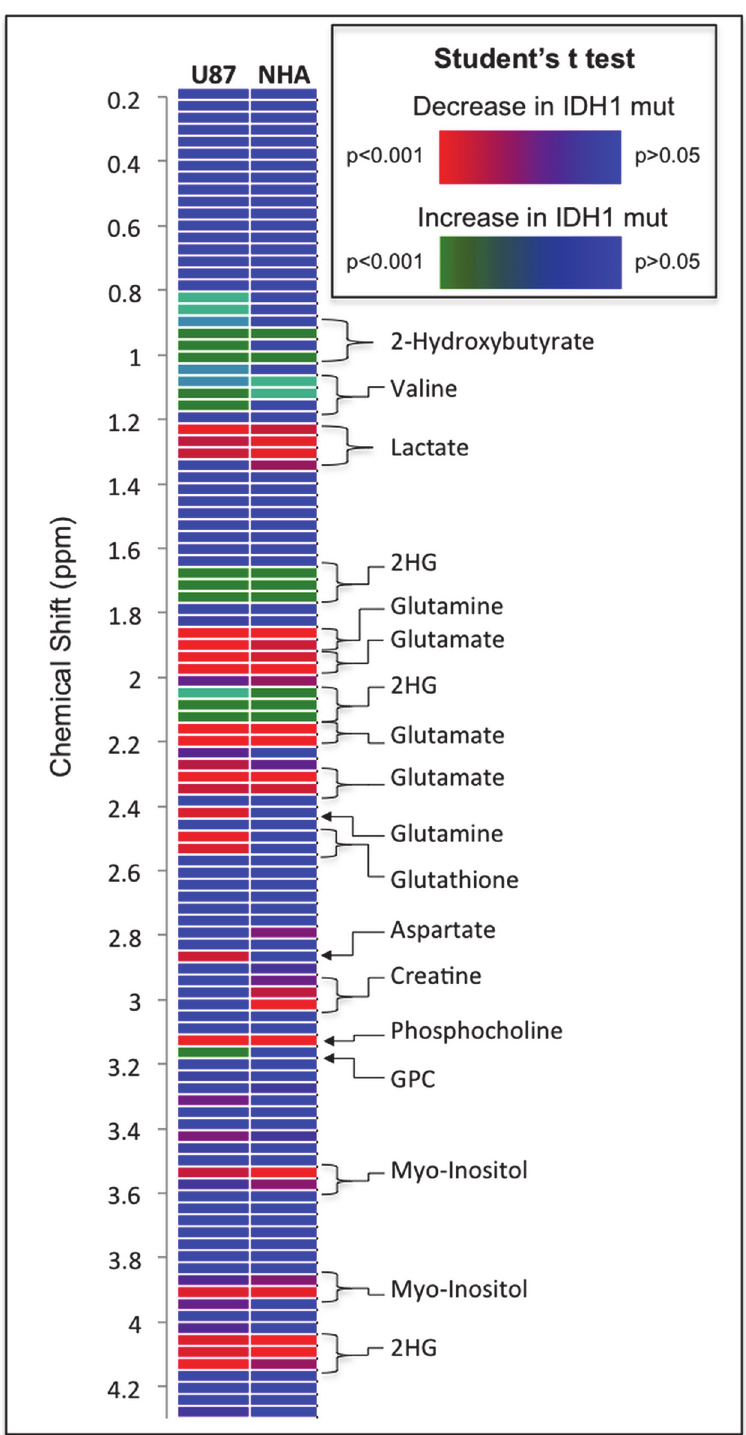
Fig 5. Chemical shift positions and the modulation of peak intensities resonating at that chemical shift when comparing IDHwt and IDHmut U87 and NHA cells. The color scale reflects the results of an unpaired Student ’ s t test applied to the spectral data. All non-significant changes (P > 0.05) are shown in blue, the significant increases and significant decreases in IDHmut cells are shown in green and red